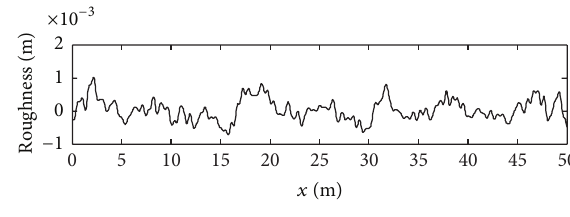
Figure 2: A typical profile of roughness.